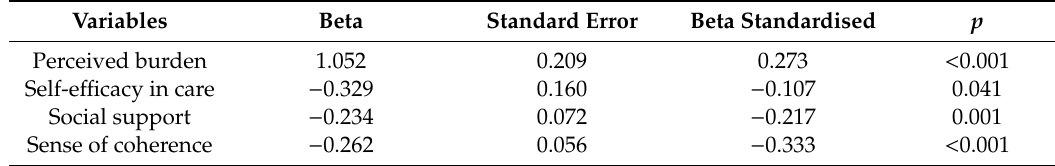
Table 4. Multiple linear regression by steps (dependent variable: